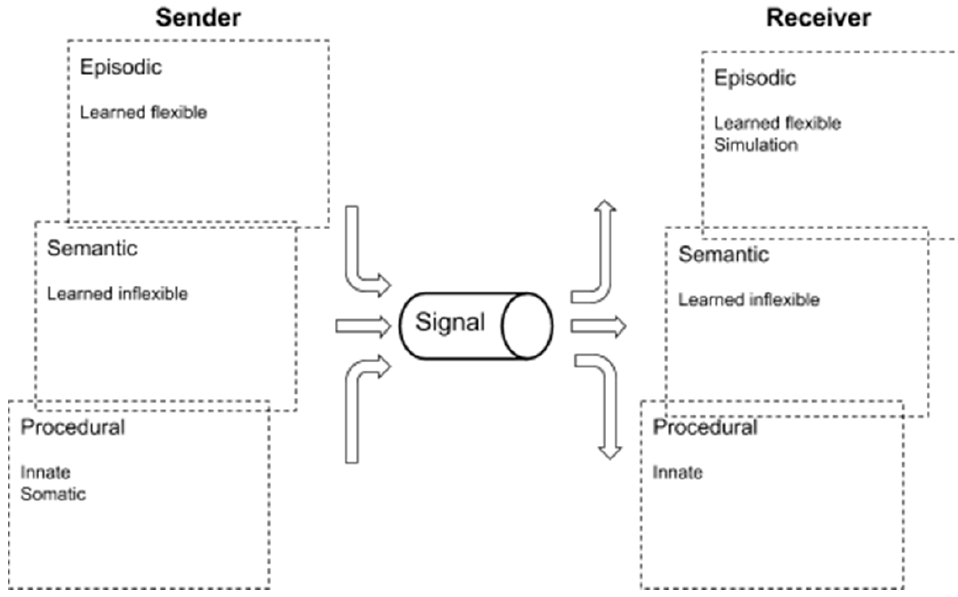
Figure 1. Schematic sketch of the communicative sender and receiver.